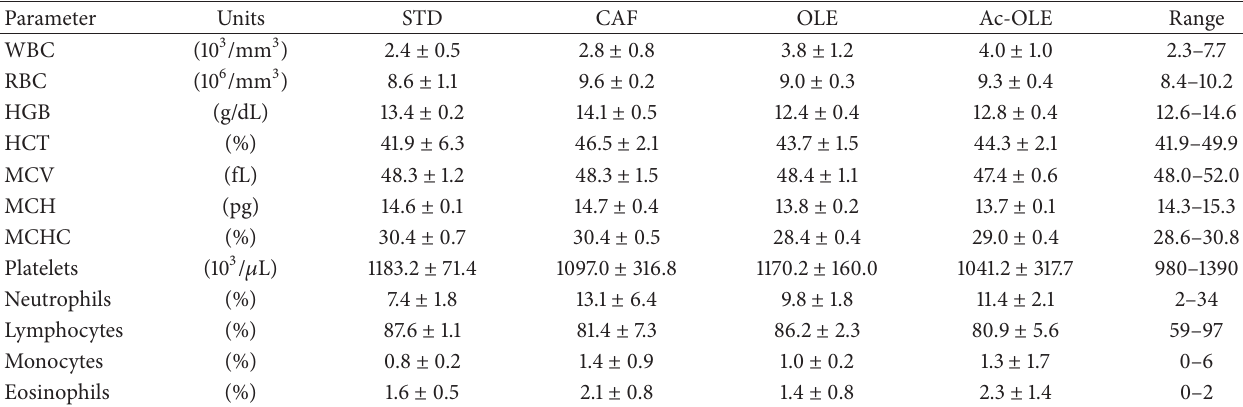
Table 2: Effects of Ole and Ac-Ole on hematological parameters.